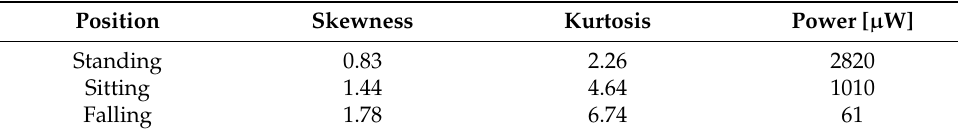
Table 1. Statistical parameters for movement